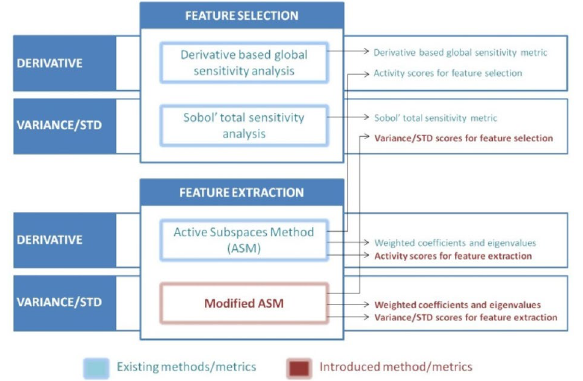
Figure 2. Overview of derivative and variance/STD based methods and metrics for feature selection and feature